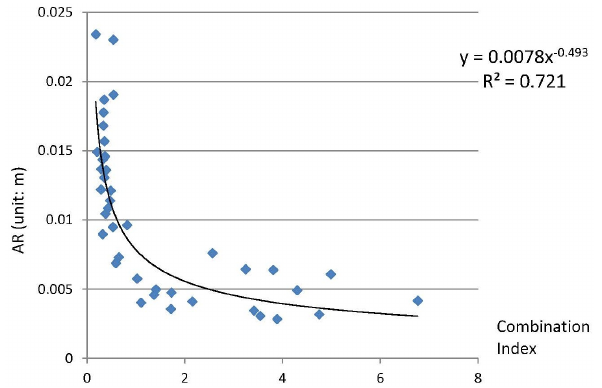
Figure 5. Relationship between the combination index (CI) and the field AR.